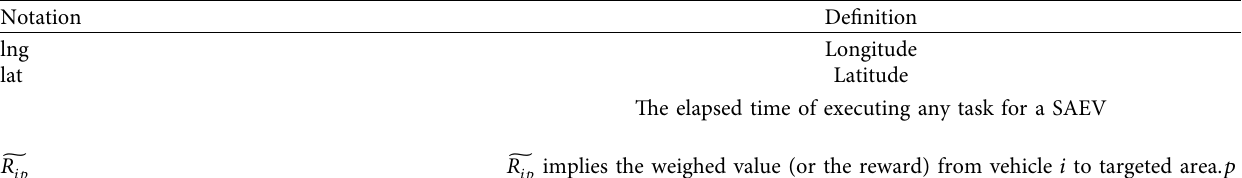
Table 2: Description of model